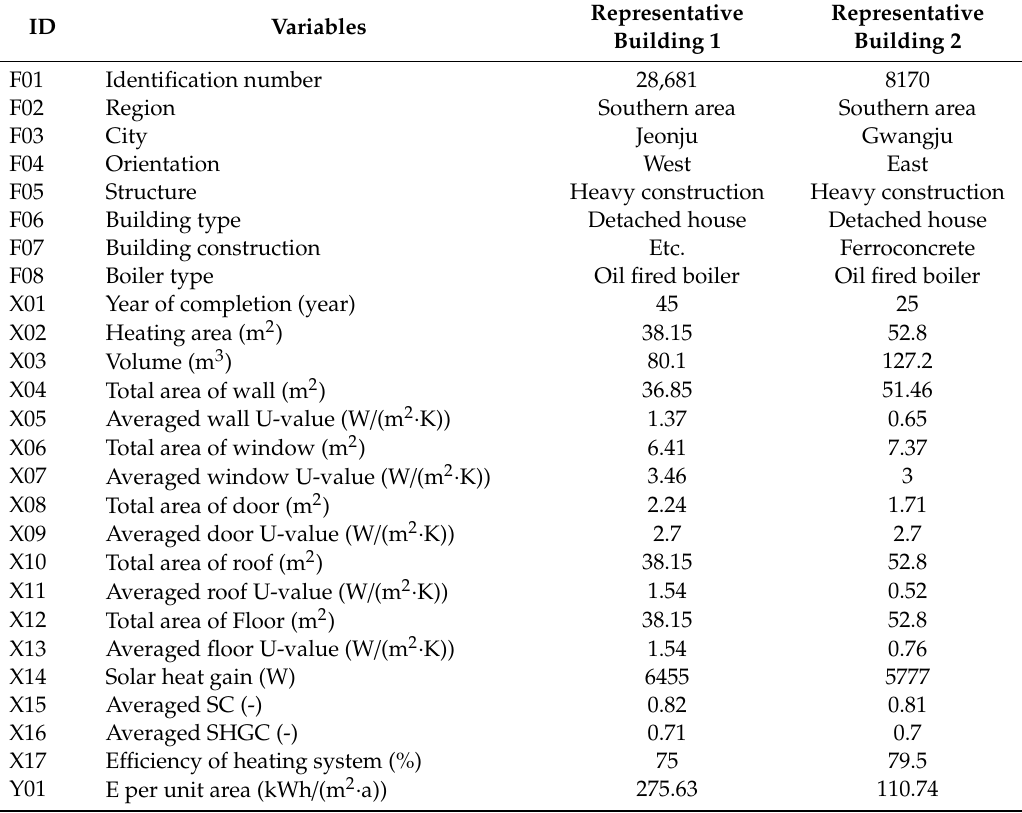
Figure 7. Process of deriving representative buildings of existing domestic houses. Table 10. Data on existing residential representative buildings in Korea.